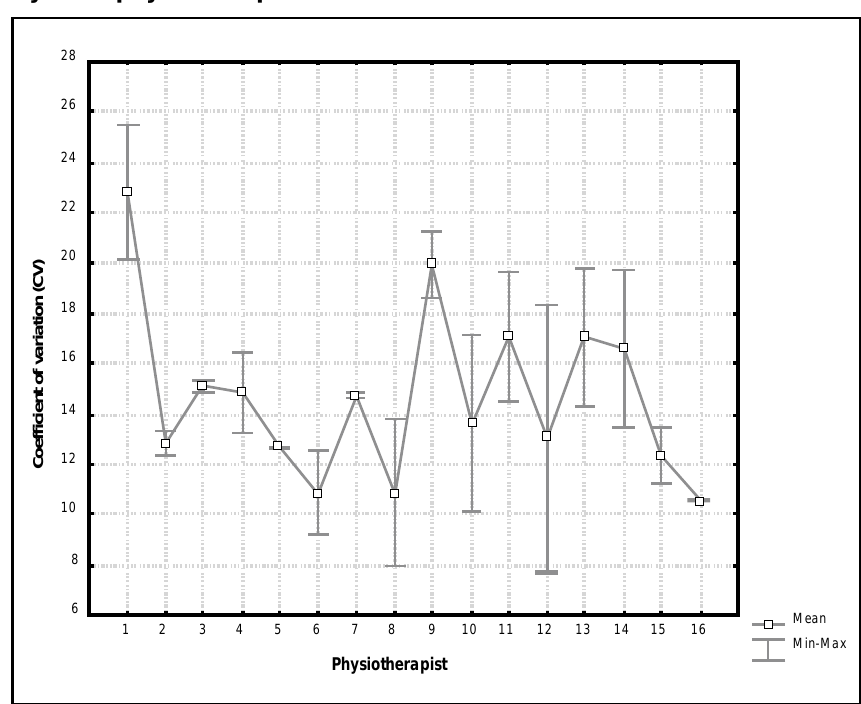
Figure 4: The coefficient of variation (CV) of the average maximum peak force during a grade I p-a passive mobilization technique on C6, applied by each physiotherapist for the first and second measurement.